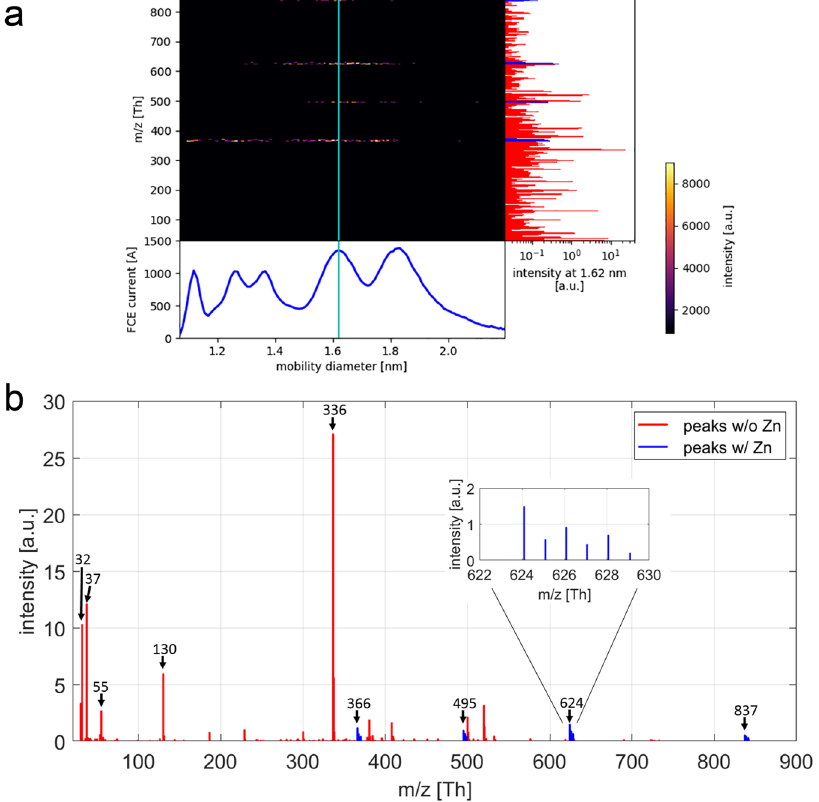
Figure 5. ( a ) 2D-mass-mobility plot of the LMW Zn complex showing ion intensities of Zn containing mass peaks using ESI-UDMA-APi-TOF mass spectrometry. Lower panel, ion mobility diameter recorded with the Faraday cup electrometer (FCE). The cyan line marks the mobility diameter of 1.62 nm. Right panel, mass spectrum recorded at the mobility diameter of 1.62 nm. Zn containing ion peaks are shown in blue. ( b ) Detailed mass spectrum showing four zinc containing peaks with characteristic zinc isotope